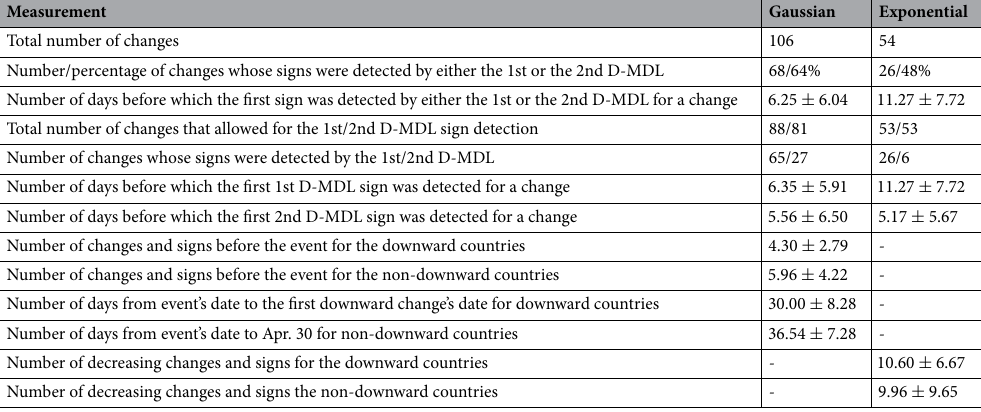
Table 2. Summarization of statistics where changes represent the alarms raised by the 0th D-MDL and signs were alarms raised by either the 1st or the 2nd